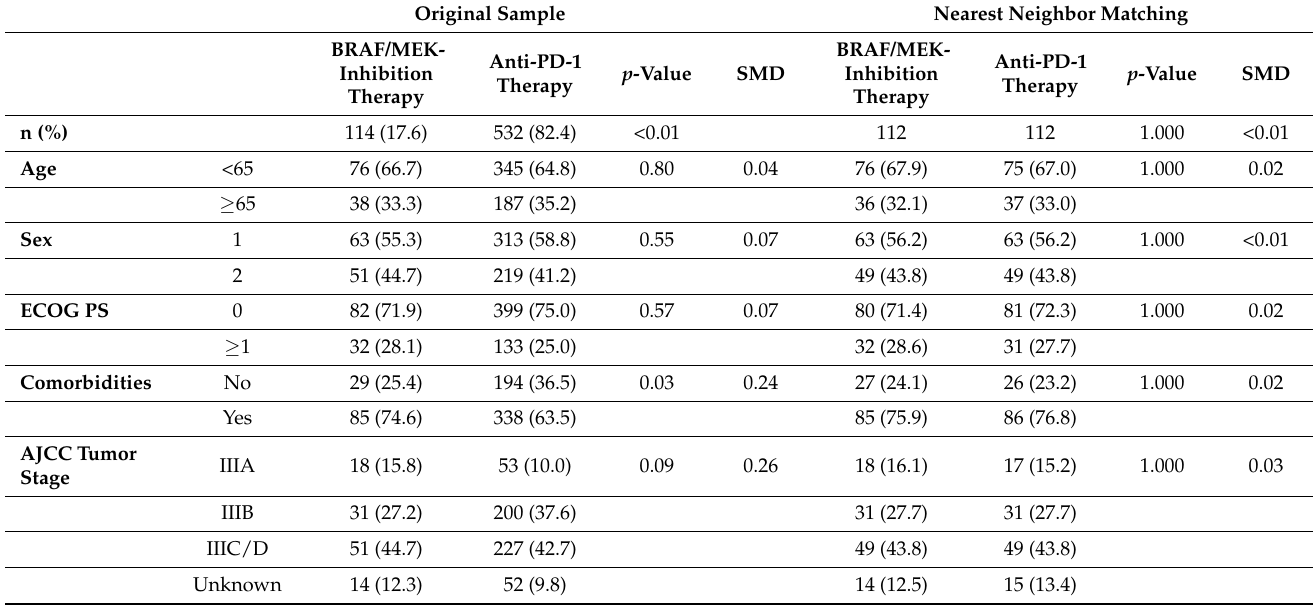
Figure 1. Flowchart study of the population. Created with BioRender.com. Table 1. Patient and tumor characteristics of cutaneous melanoma patients treated with adjuvant BRAF/MEK-inhibition therapy and adjuvant anti-PD-1-treated patients.